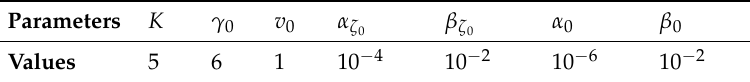
Table 1. Parameters for JMAP and VBA algorithms.